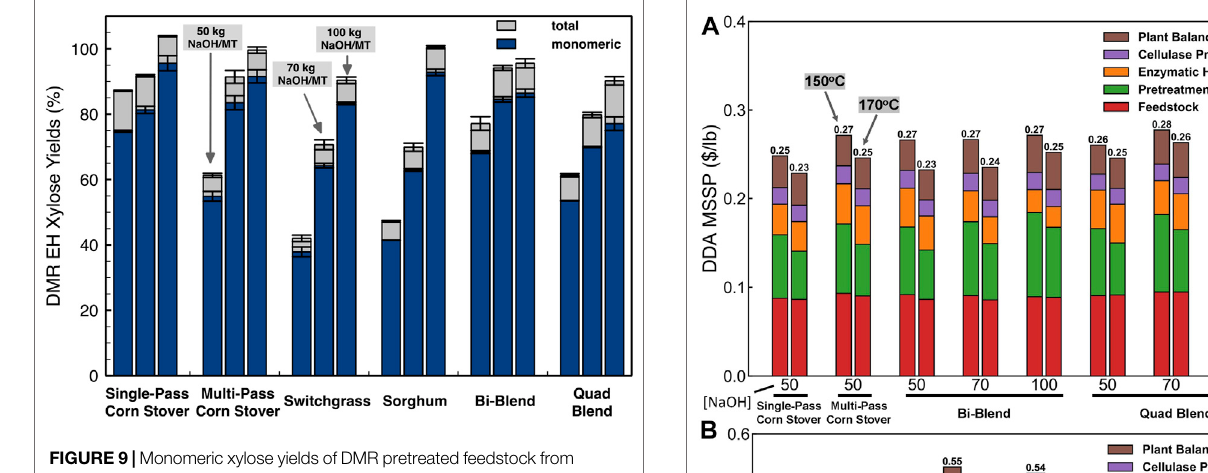
FIGURE 9 | Monomeric xylose yields of DMR pretreated feedstock from high solids enzymatic hydrolysis at 20% initial insoluble solids. The enzymatic hydrolysis was conducted at an enzyme loading of 12 mg total protein/g glucan using an 80:20 mixture of Novozymes Cellic CTec3/HTec3 at 50 ° C for 7 days. Bars and error bars show the average and the standard deviation, respectively, of two replicated experiments.